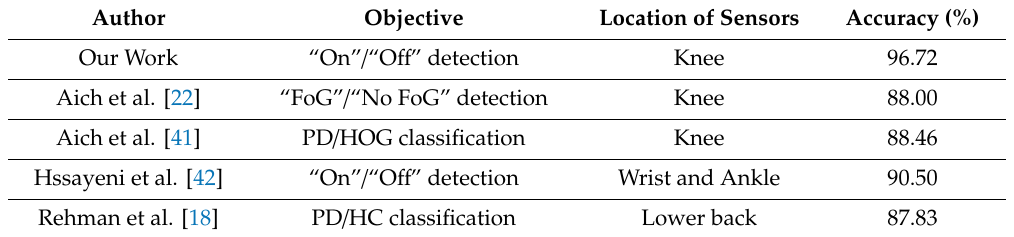
Table 9. A comparison of our results with state-of-the-art models’ work for activity detection.